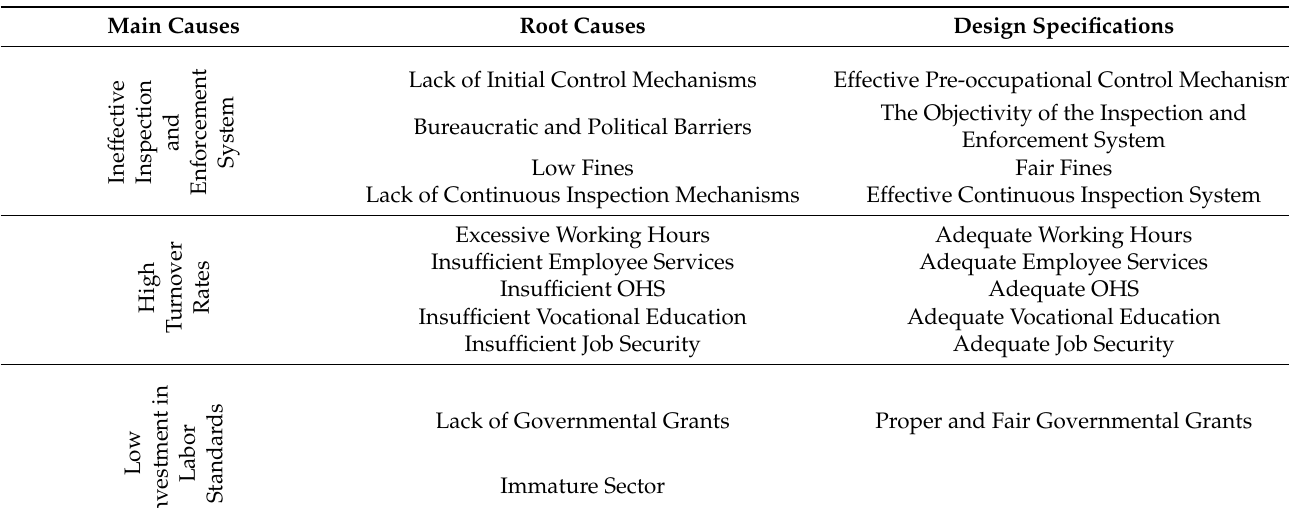
Table 4. Root Causes and Design